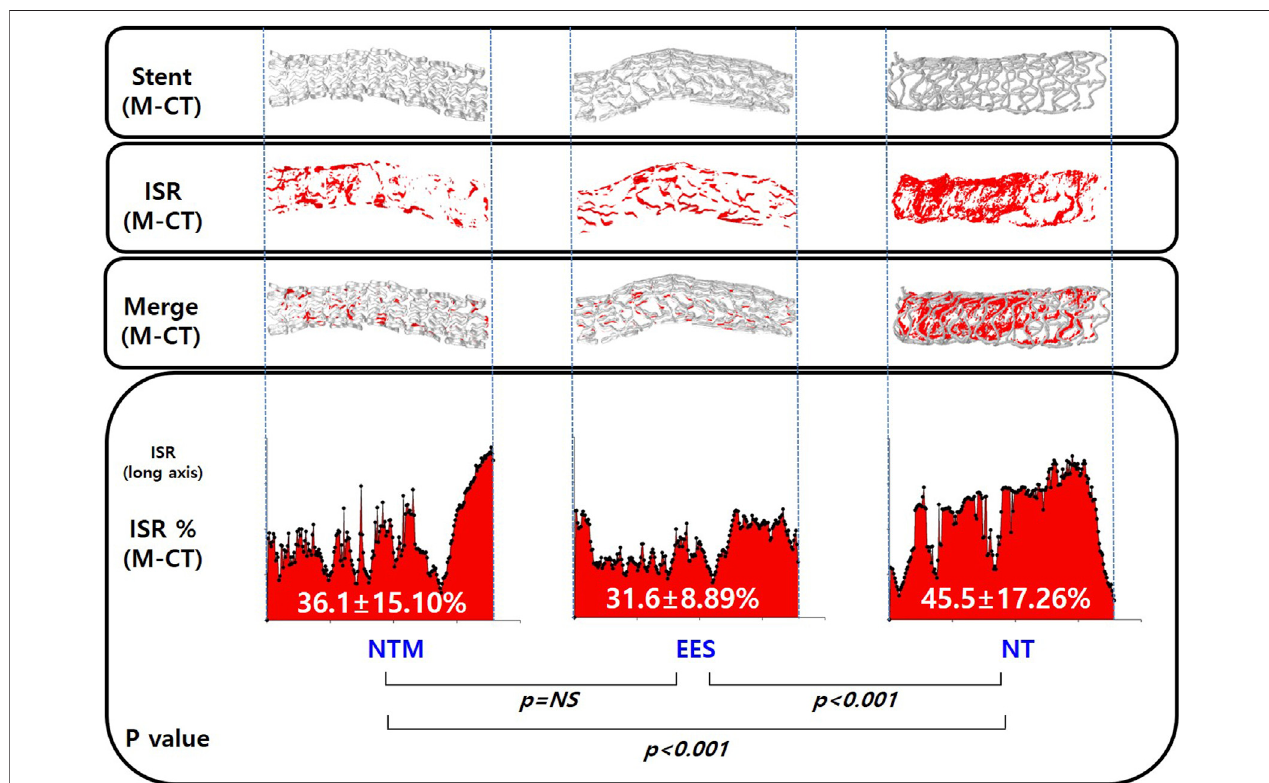
FIGURE 7 | Micro-computed tomography analysis of in-stent restenosis in NTM, EES, and NT. NTM, TiO 2 fi lm – coated stent with mycophenolic acid; EES, everolimus-eluting stent with biodegradable polymer; NT, TiO 2 fi lm – coated stent.